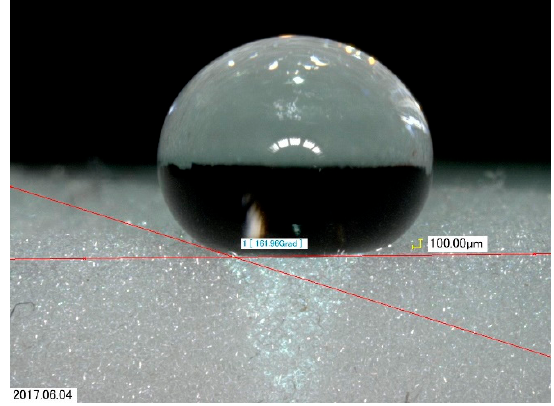
Figure 11. Contact angle measurement of a water drop on the superhydrophobic filter.